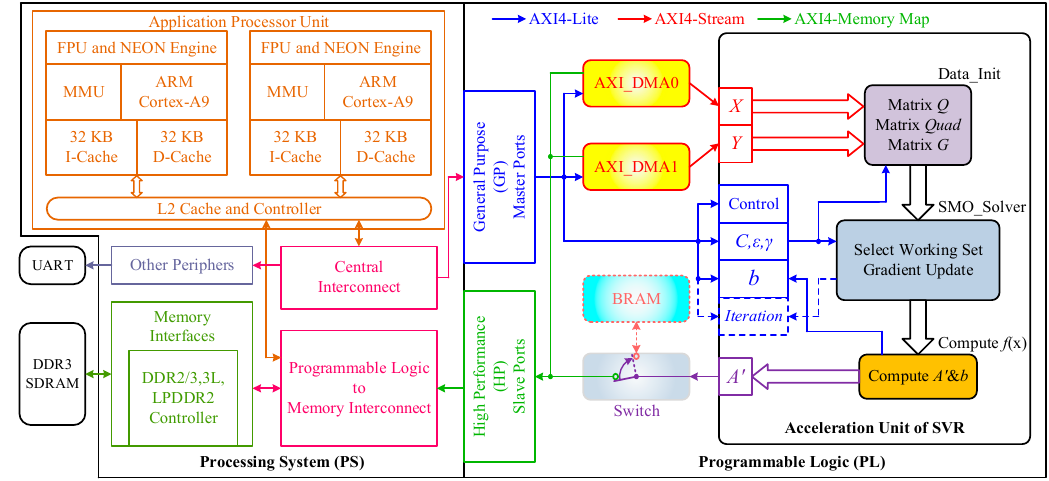
Figure 6. Schematic diagram of the acceleration unit.